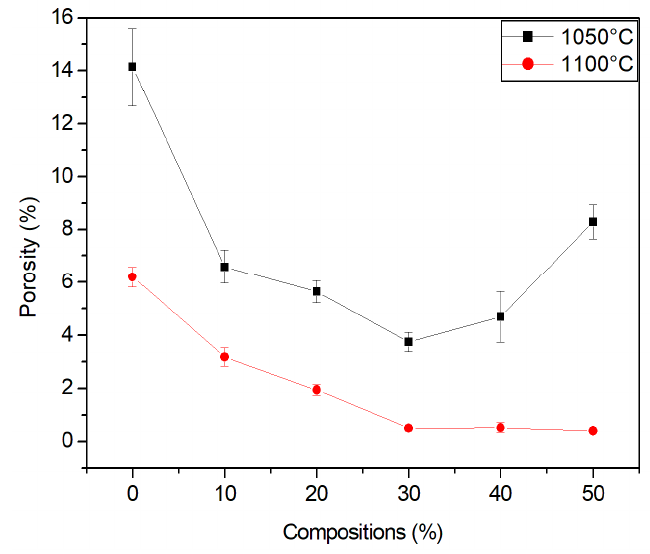
Figure 11. Porosity of ceramic material.